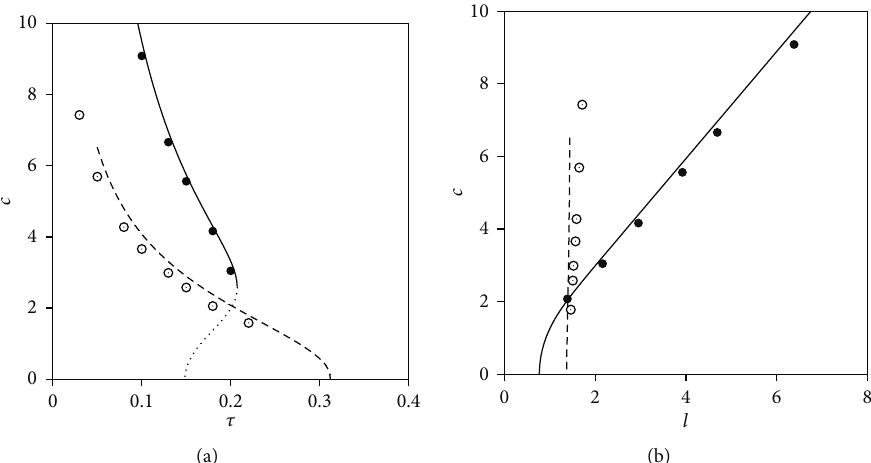
Figure 4: Dependence of traveling speed c on τ and pulse width l . Symbols • and ∘ represent simulation results of the RD system (1) in the case of α = 0 and 3, respectively. (a) Dependence of speed on τ . Solid curve represents the case of α = 0 and which connects with the unstable ). Dashed curve represents the case of α = 3 with s = 1 .4. τ ~ 0 : 312 . (b) Dependence of speed on l . branch (dotted curve) at τ ~ 0 : 2072 ( ≡ τ 0 c c = 1 .4, Solid and dashed curves represent the cases of α = 0 and α = 3 with s 0